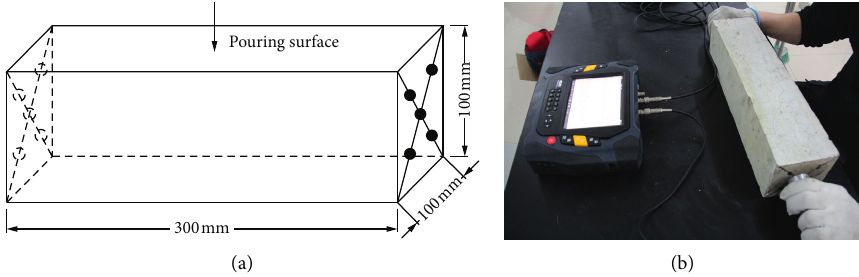
Figure 4: Ultrasonic test. (a) Schematic diagram of ultrasonic testing. (b) Actual diagram of ultrasonic